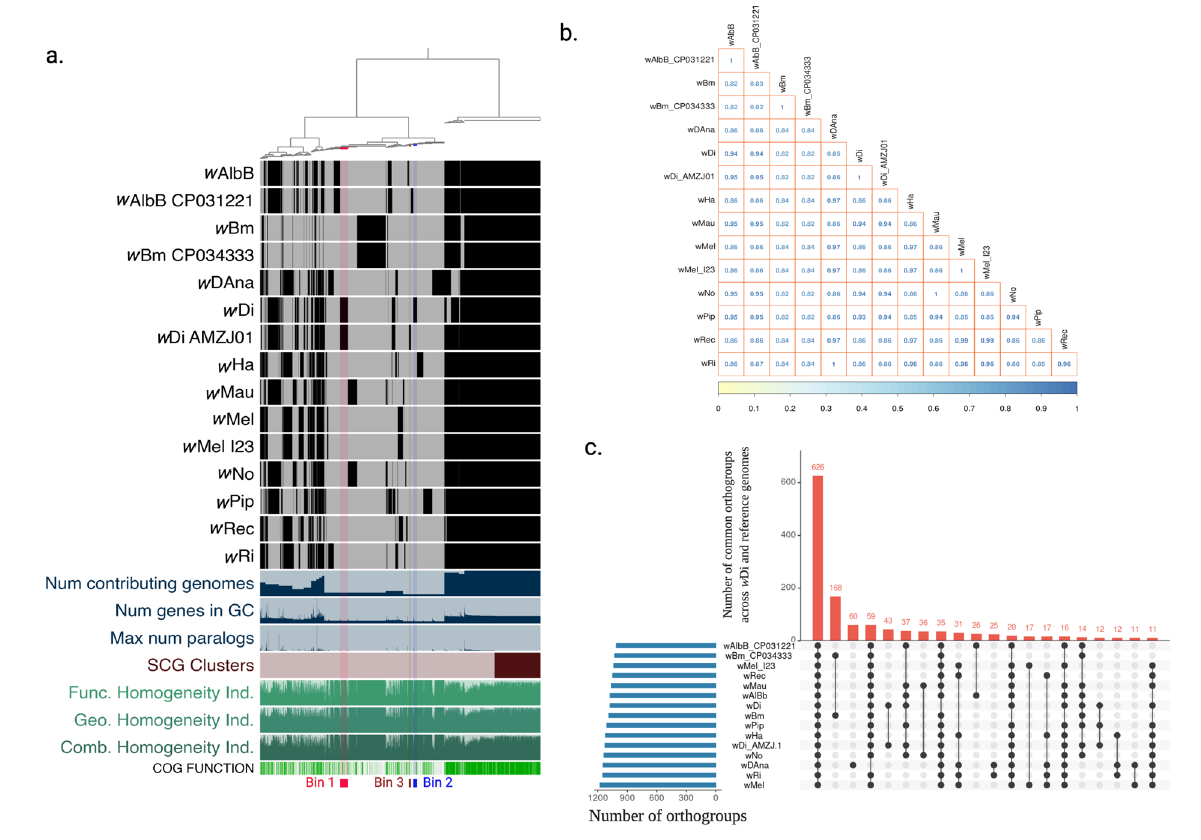
Figure 6. Comparative genomics of Wolbachia genomes. ( a ) Wolbachia metapangenome representing 2,112 gene clusters with 18,800 genes that were identified in 15 Wolbachia genomes. The metapangenome represent following parameters: combined homogeneity index, geometric homogeneity index, functional homogeneity index, Single-copy Core Genes (SCG) clusters, maximum number of paralogs, number of genes in gene cluster (GC), number of genome gene clusters that have hits. Regions of the map shown in black denote similar content between genomes. The dendrograms on the top represents the hierarchical clustering of genomes based on the occurrence of gene clusters. ( b ) The Average Nucleotide Identity (ANI) between the w Di genome and 14 genomes of Wolbachia evaluated using the ‘anvi-compute-ani’ which utilizes PyANI 56 in ‘ANIb’ mode to compute average nucleotide identity across the genomes anvio v5.5.0 57 . ( c ) UpSet plot showing number of common orthogroups across w Di and reference Wolbachia genomes. 626 orthogroups were present in all Wolbachia strains analyzed which is represented by the first bar. The fifth bar represents 43 orthogroups unique to w Di genomes. The black and gray dots represent the presence and absence of orthogroups, respectively, in each Wolbachia